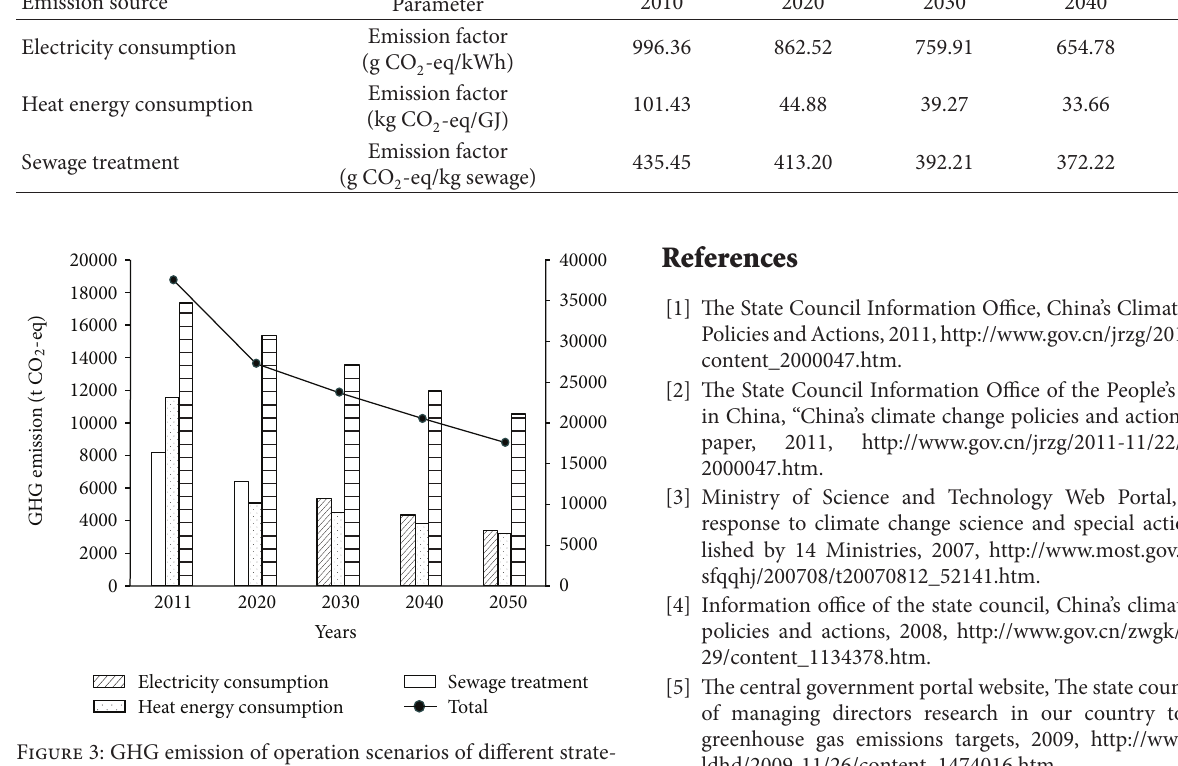
F 3: GHG emission of operation scenarios of different strate-